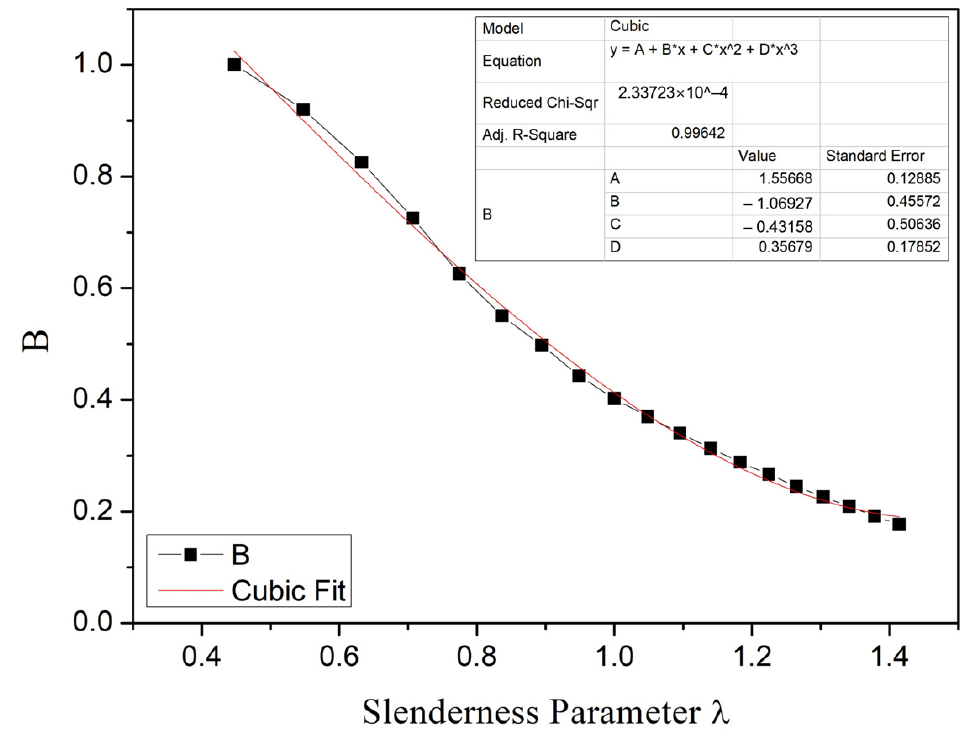
Figure 10. Regression Analysis for Coefficient B.